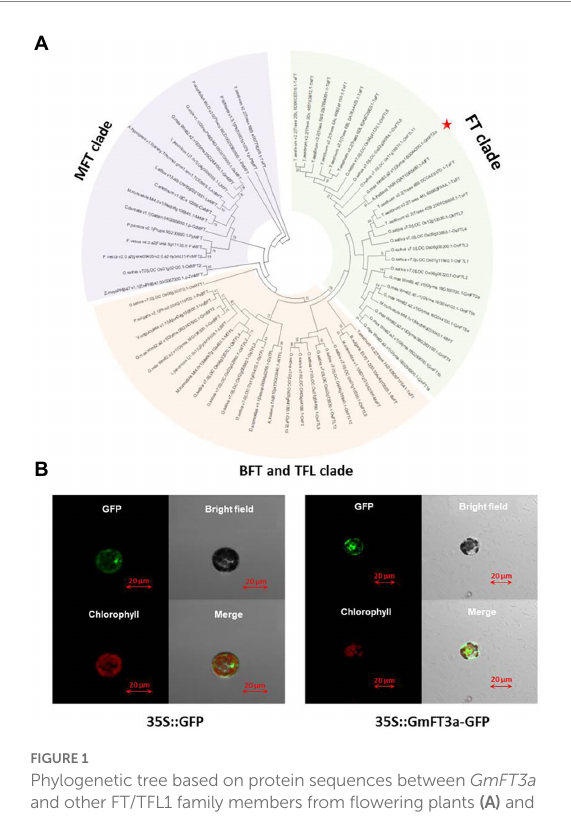
FIGURE 1 Phylogenetic tree based on protein sequences between GmFT3a and other FT/TFL1 family members from flowering plants (A) and subcellular localization of GmFT3a-GFP fusion protein in Arabidopsis protoplasts. The left four panels are 35S::GmFT3a- GFP constructs, and the right four panels are controls (35S::GFP) (B)